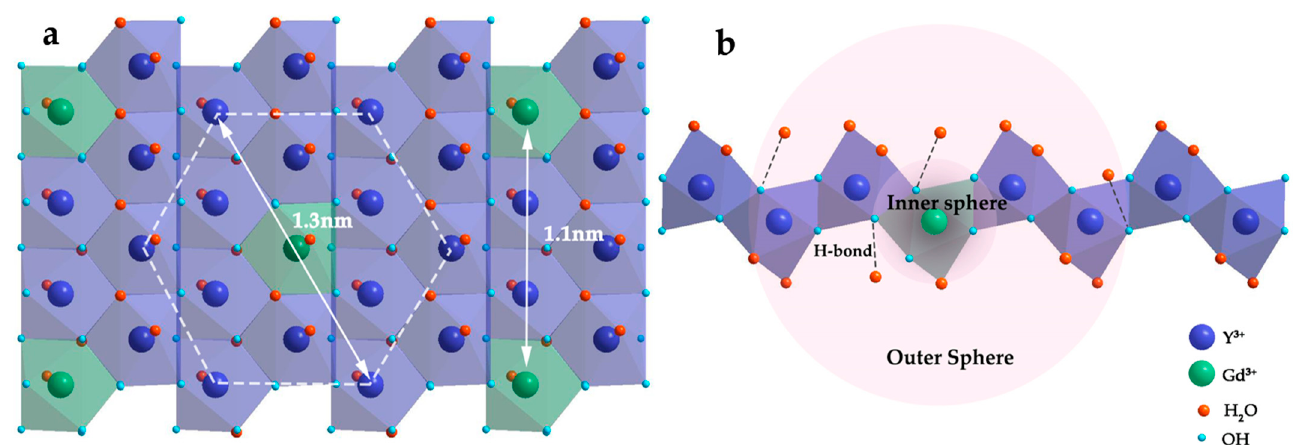
Figure 6. Structural schematics of the 10% Gd-LRH nanosheets ( a ) and cross section structure of basic cell in the 10% Gd-LRH nanosheets ( b ).